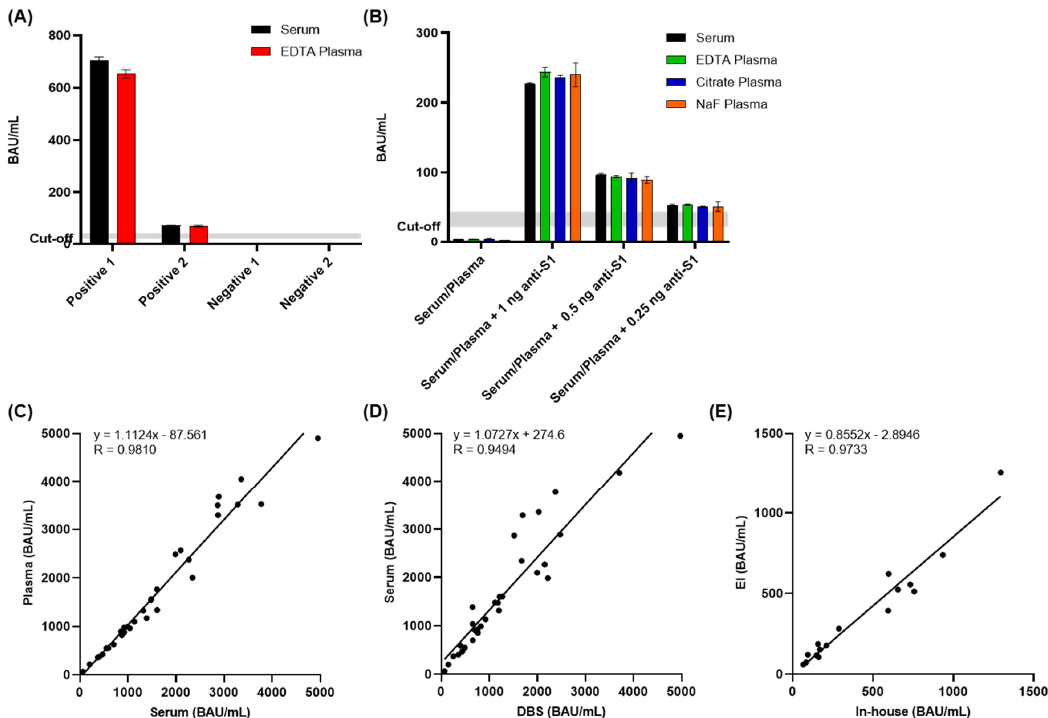
Figure 3. Equivalence of sample matrices. ( A ) Comparison of serum (black) and EDTA plasma (red) samples from two patients collected >14 days after symptom onset and two negative patients. ( B ) Serum (black), EDTA plasma (green), citrate plasma (blue), and NaF plasma (orange) were spiked with anti-S1 antibody. ( C ) Correlations between 32 positive serum and plasma samples collected from vaccinated donors (R = 0.9810). ( D ) Correlations between 32 positive serum and capillary blood DBS collected from vaccinated donors (R = 0.9494). ( E ) Correlations between in-house ELISA to EUROIMMUN quantitative ELISA using 16 whole-blood DBS samples collected from vaccinated donors (R = 0.9733).